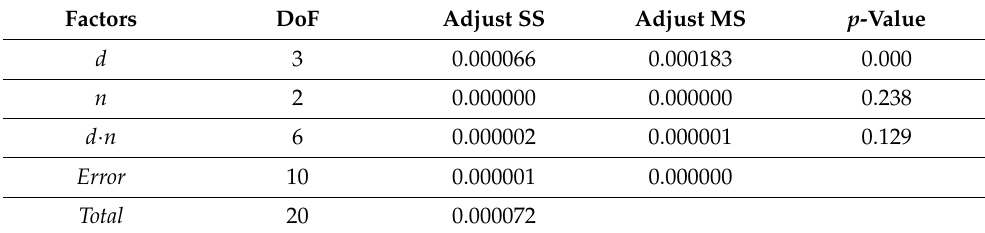
Table 6. Results of the ANOVA for the FP2 testing plan.